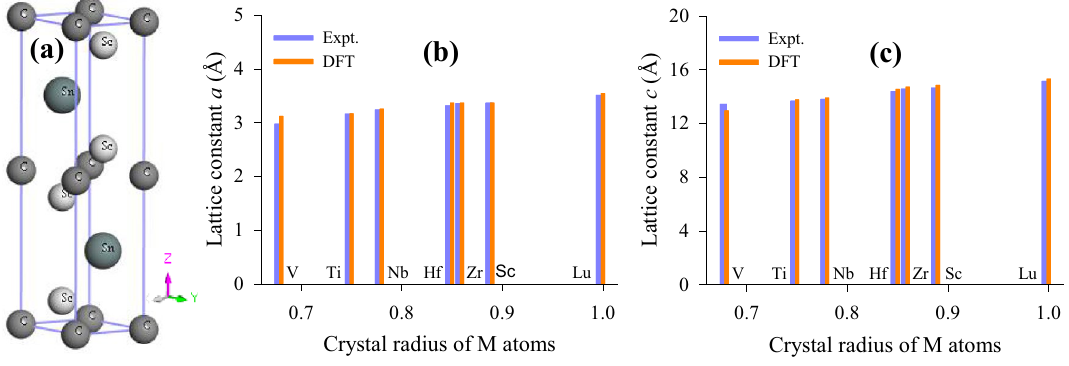
Figure 1. ( a ) Conventional unit cell of Sc 2 SnC as a structural model of 211 M 2 SnC MAX phases; ( b ) lattice constants a and ( c ) lattice constants c increase with crystal radius of M atoms.